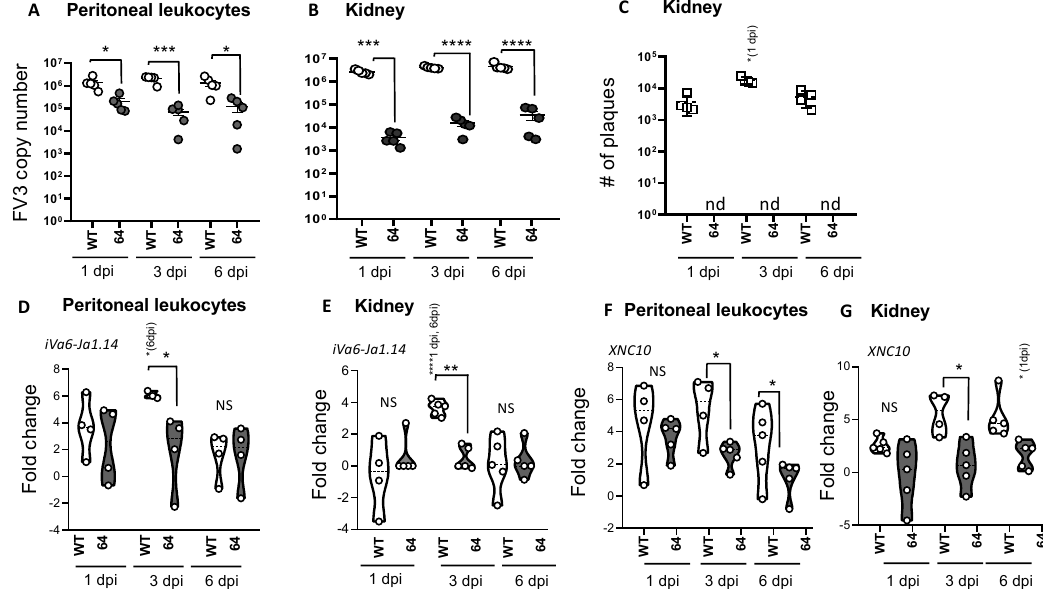
Figure 2. Magnitude of iV α 6 T cell response in adult frogs is associated to the level of viral replication and production of infectious particles. PLs and kidneys were collected at 1, 3, and 6 dpi from adult frogs infected with 1 × 10 6 PFUs of WT-or ∆ 64-FV3. FV3 genome copy number by absolute qPCR in PLs ( A ) and kidneys ( B ) were determined. The total number of infectious particles (nd: not detected) in the kidney was determined by plaque assay ( C ).Gene expression of iV α 6-J α 1.43 and XNC10 in PLs ( D , F ) and kidneys ( E , G ) were determined relative to an endogenous control (GAPDH) and fold changes were calculated using mock-infected frogs as a control. Each dot represents an individual animal ( n = 4–5). The line intersecting the y -axis at 0 represents the APBS control that the fold changes of the treatments are in relation to. Note: * p < 0,05; ** p < 0.01; *** p < 0.001, and **** p < 0.0001 above the line denotes statistically significant di ff erences between the di ff erent treatment groups; significant di ff erences between time points within each treatment group are indicated within parentheses; NS indicates no significant di ff erences (one way ANOVA and Dunns’s multiple comparison